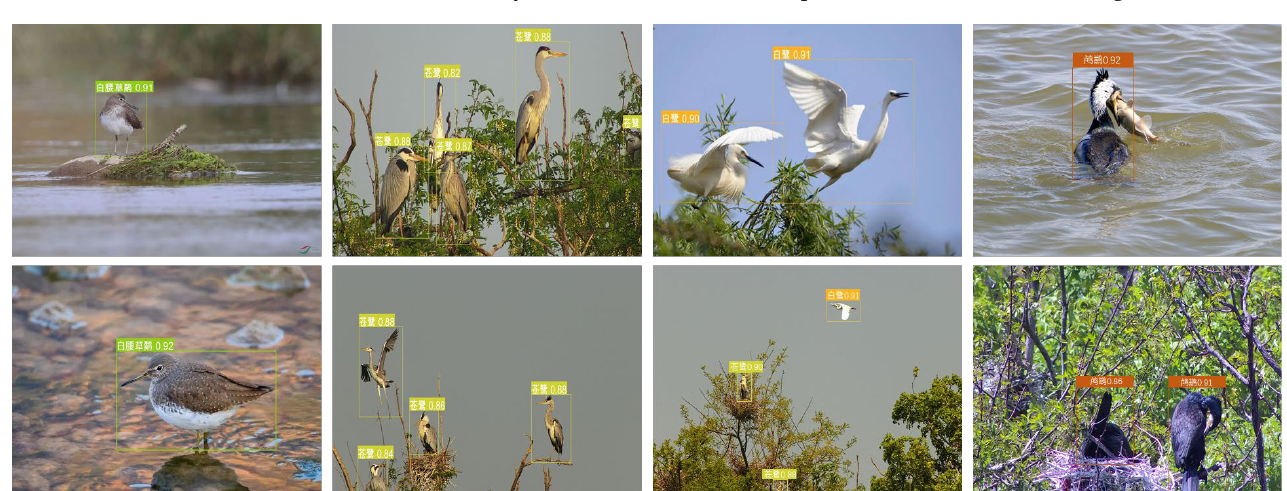
Figure 7. The detaching results obtained by optimized YOLOV5 model.